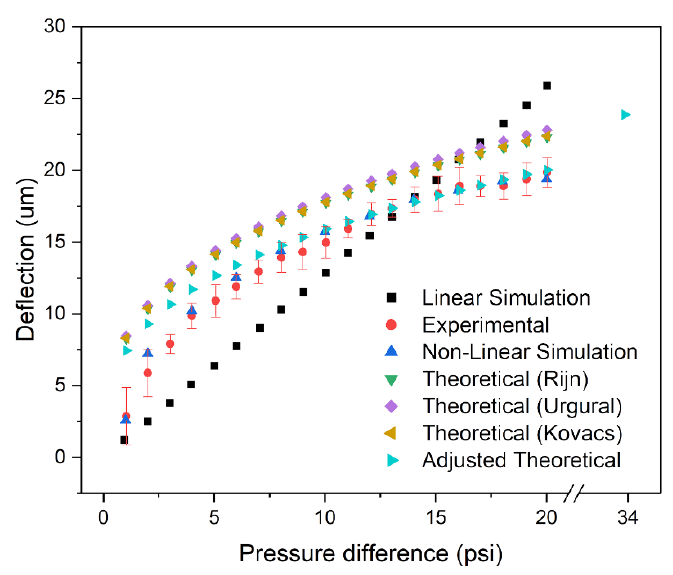
Figure 6. Experimental, theoretical, and simulation results of the maximum membrane deflection (apex). Error bars indicate standard deviation ( n = 5).